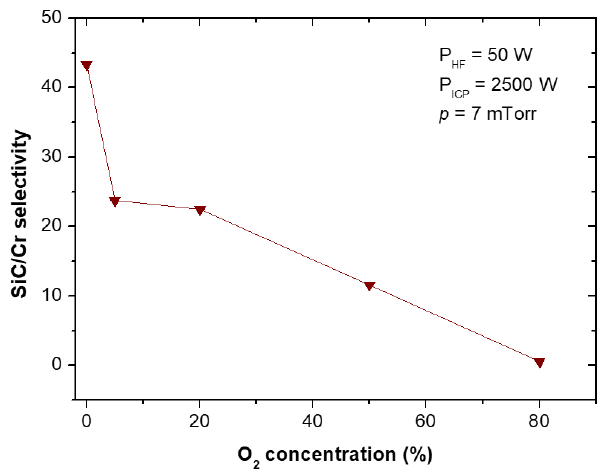
Figure 11. SiC/Cr selectivity vs. oxygen concentration in the SF 6 plasma. Fixed parameters are included in the inset.